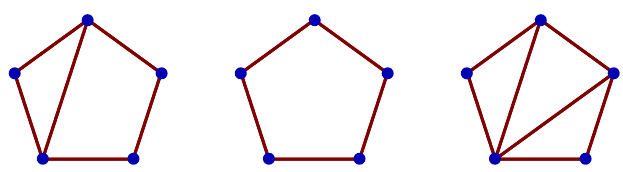
Figure 6 . ELC-equivalent (T-dual equivalent) graphs corresponding to n = 5 code with the largest d = 3 , d b = 3 , W = x 5 + 5 x 2 y 2 z + 5 x 2 z 3 + 10 xy 2 z 2 + 5 xz 4 + 5 y 2 z 3 + z 5 and Q =